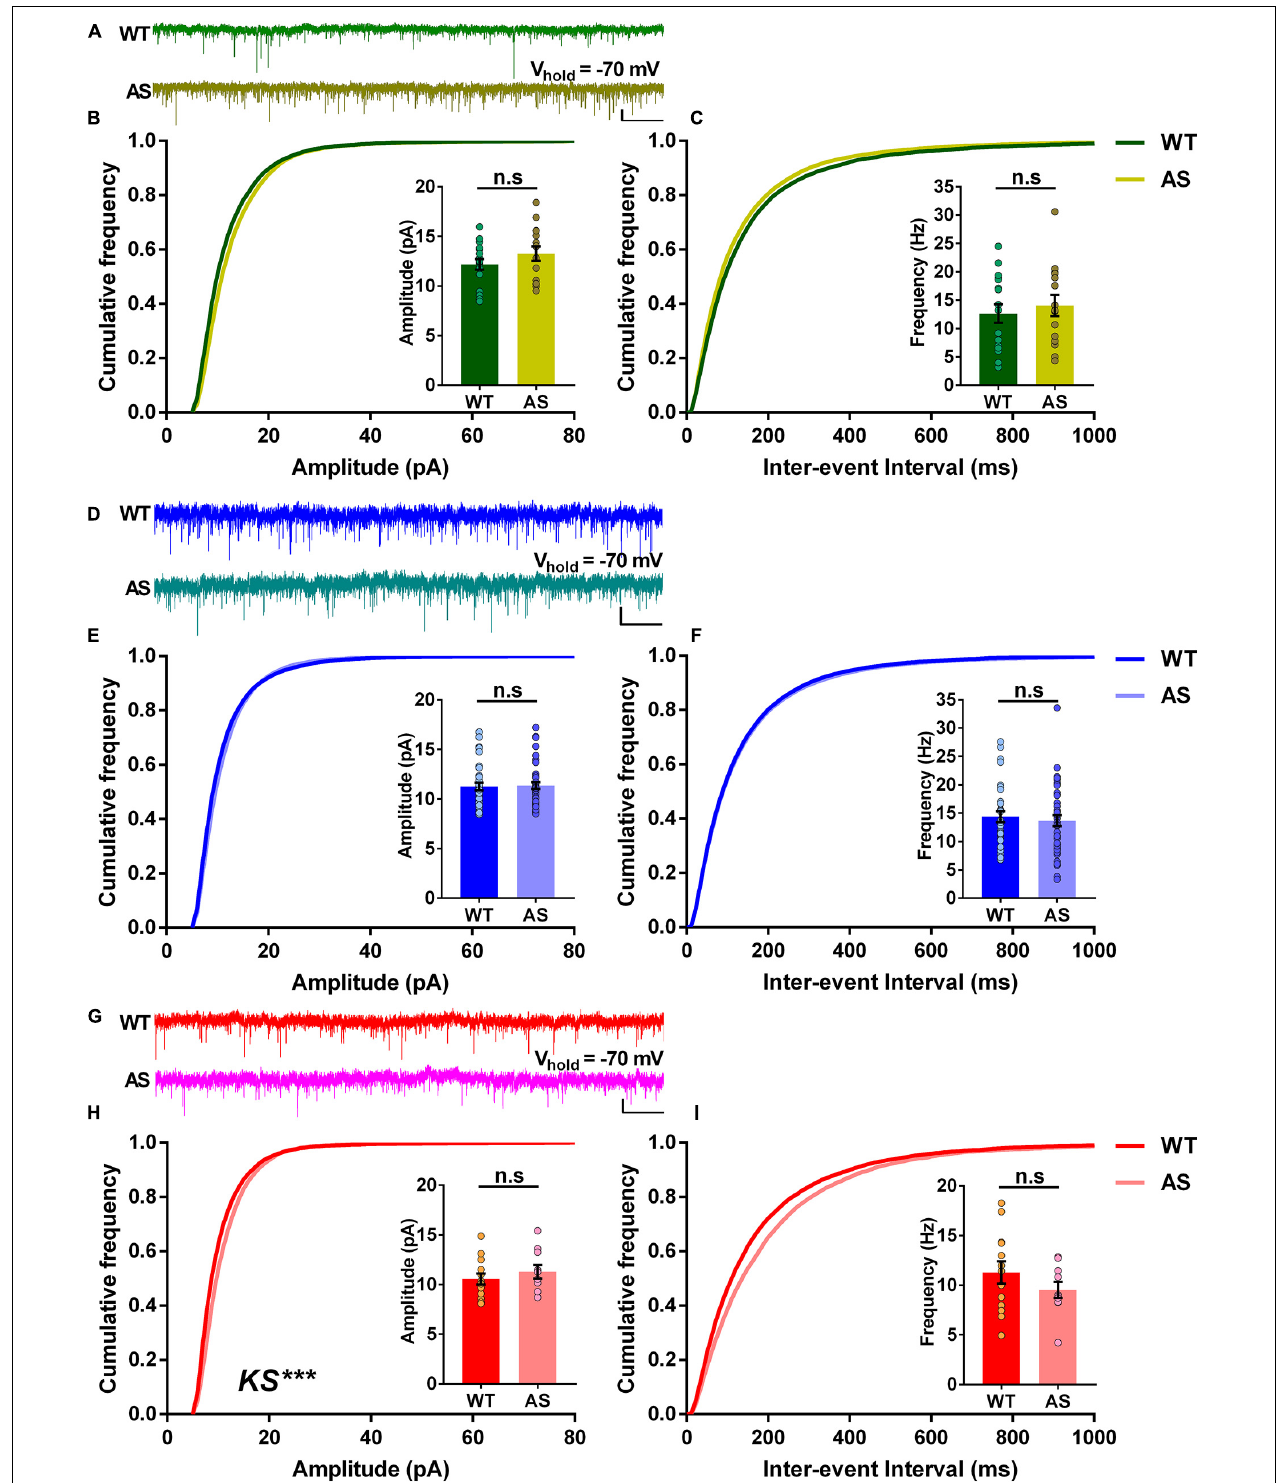
FIGURE 5 | The spontaneous excitatory postsynaptic currents (sEPSCs) of different subicular PNs remain unaltered in AS mice. (A) Representative voltage-clamp traces of sEPSCs recorded from RF subicular PNs of WT (green) and AS (olive) mice. sEPSCs from different subicular populations were recorded by holding the cells at –70 mV. (B) Cumulative probability plots of sEPSC amplitudes and (C) inter-event intervals of the RF subicular PNs in WT and AS mice. The cumulative frequency distribution of AS mice shows no differences in amplitudes [KS test, p = 0.40] and inter-event intervals [KS test, p = 0.21] when compared to their WT